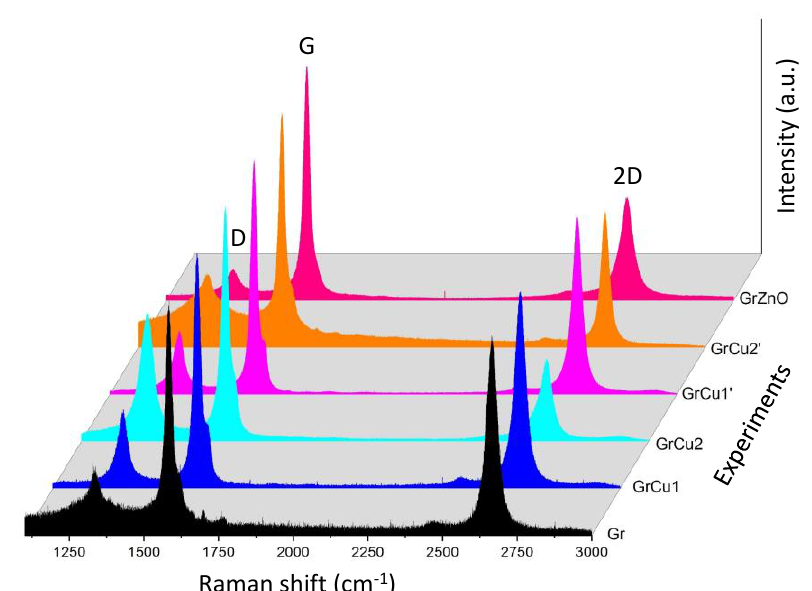
Figure 2. Raman spectra of the synthesized graphene and graphene hybrids in the helium arc discharge method in the conditions of Table 1.